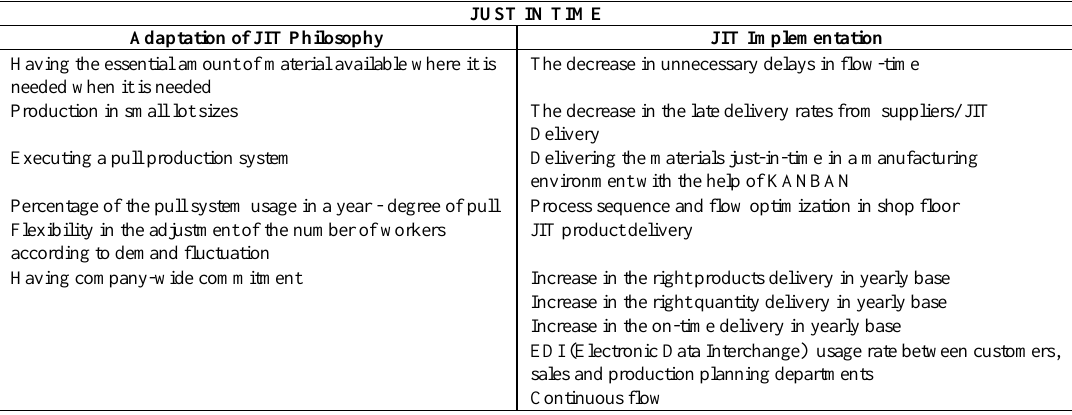
Table 6. Sub-criteria and measures for the just-in-time main criterion JUST IN TIME Adaptation of JIT Philosophy JIT Implementation